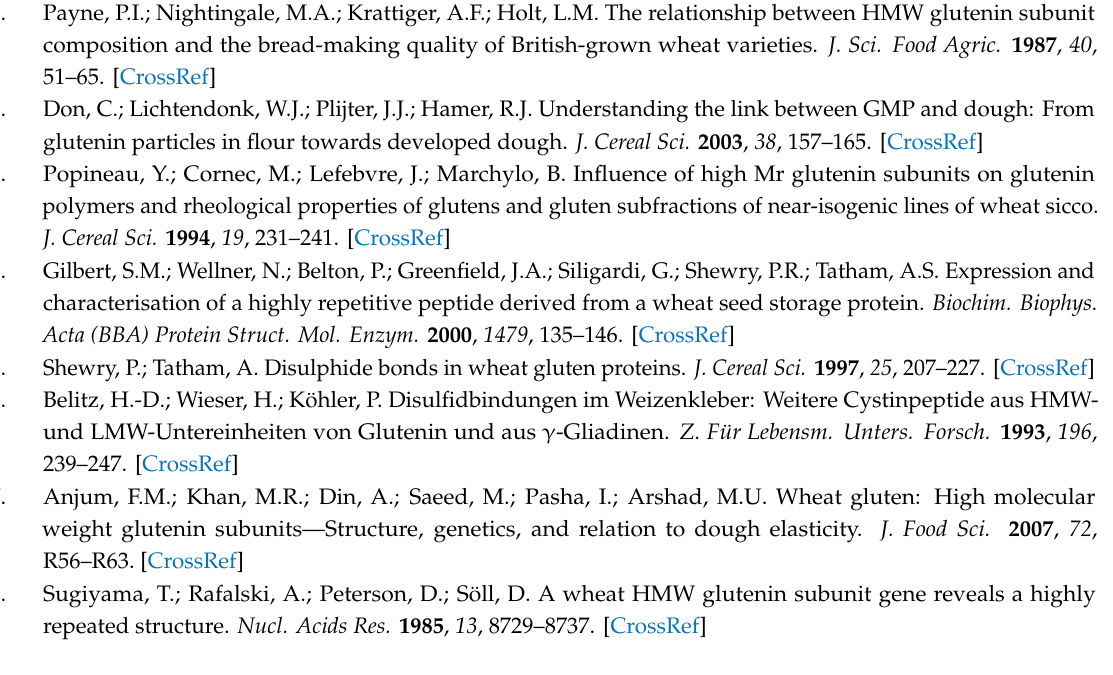
Supplementary Materials: The Supplementary Materials are available online. Figure S1: The γ / β -turn structure of WRS in three states. Figure S2: The γ / β -turn structure of DRS in three states. Figure S3: Conformational change of repetitive sequence in the redox cycle of wPDI. Figure S4: Statistics of interactions between repetitive sequence and